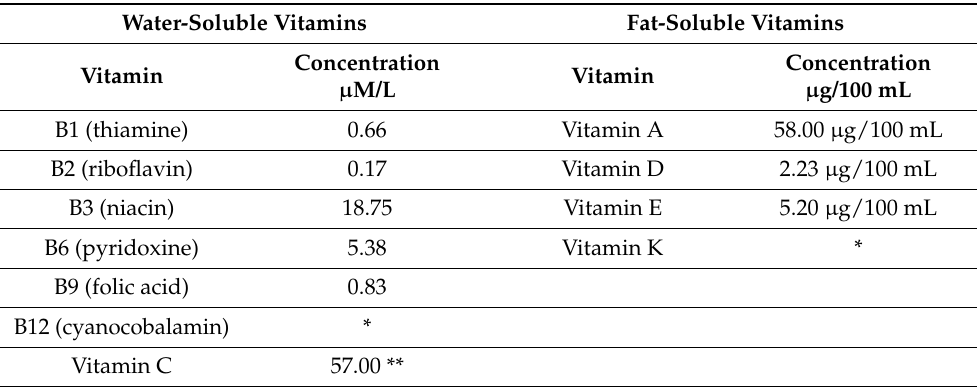
Table 4. Vitamin content in donkey milk [2,49,56,57]. Water-Soluble Vitamins Fat-Soluble